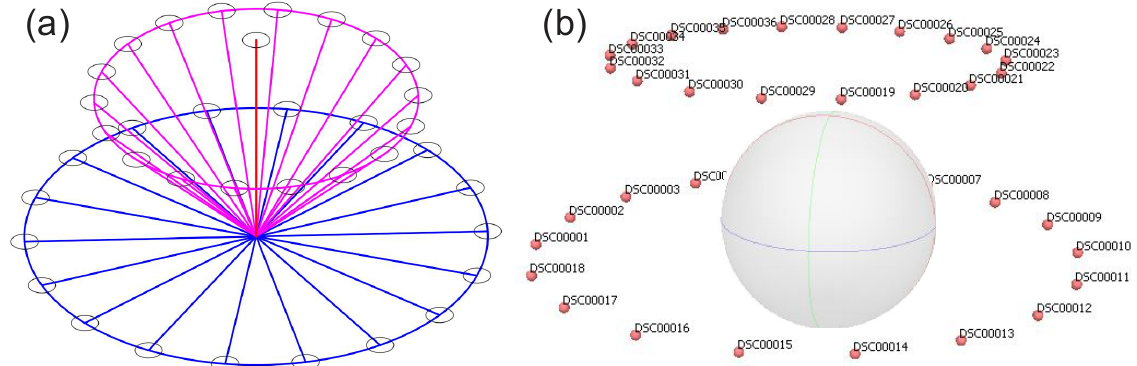
Figure 11. Representative model of ground image collection positions. ( a ) The blue lines represent the images at zero degrees of elevation. Magenta lines represent images with 45 degrees of elevation, and the red axis represents the Z axis. The small blue circles represent the images. ( b ) The positions of the images in the arbitrated system are imported into the processing software.